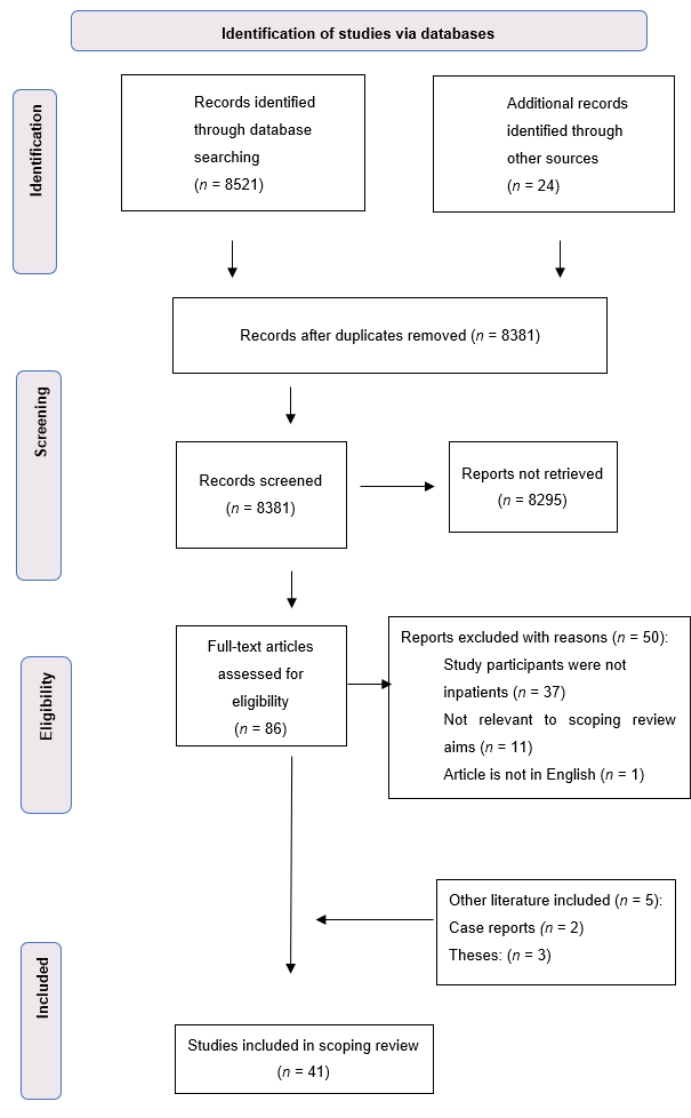
Figure 1. Flowchart of selection process.